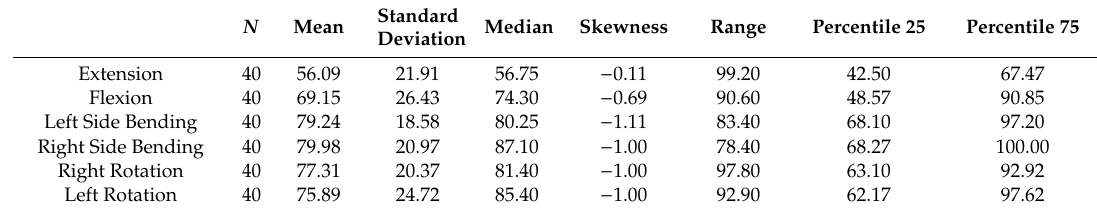
Table 7. Case group normalized values of ROM using Swinkels guidelines.